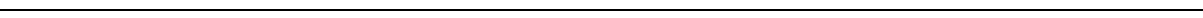
Fig. 5 Metal limitation and endocytosis. a Lucifer yellow uptake assayed by microscopy. Cells were pre-cultured on YPD, then grown on YPD or YPD/EDTA for 2 h, sedimented and resuspended in the same medium containing 2.3 mM Lucifer yellow. After 75 min of incubation, the cells were washed 5 times with PBS and analyzed by fl uorescence and differential interference contrast (DIC) microscopy. Cells depleted for ATP by NaN 3 / NaF treatment (1 mM each) were used as a negative control. Scale bar: 5 μ m. Gray values of the fl uorescence images have been inverted. b Lucifer yellow uptake quanti fi ed by fl ow cytometry. Cells were incubated with Lucifer yellow and washed as in ( a ). Their fl uorescence was analyzed by fl ow cytometry. The left panel shows a representative histogram. The right panel shows Lucifer yellow content from four independent experiments. Whiskers represent minimum and maximum of all of the data, the bottom and the top of the box show fi rst and third quartiles and the band inside the box the median. c Growth analysis of membrane traf fi cking mutants on YPD and YPD/EDTA was performed as in Fig. 4a. d ICP-MS analysis of Mg content in the endocytosis mutants vrp1 Δ and sac6 Δ , grown on YPD/EDTA, was performed as in Fig. 3a. Values per cell and per culture volume are shown. e Growth analysis of retromer complex mutants on YPD and YPD/EDTA was performed as in Fig. 4a. b – e The results represent mean ± SD of at least three independent experiments. Differences were evaluated using Student ’ s t test comparing ( b ) wild-type and vtc4 Δ cells ± 1 mM EDTA at each time point, and ( d ) vtc4 Δ and mnr2 Δ cells with wild-type at each time point; ns, non-signi fi cant, * p ≤ 0.05; ** p ≤ 0.01; *** p ≤